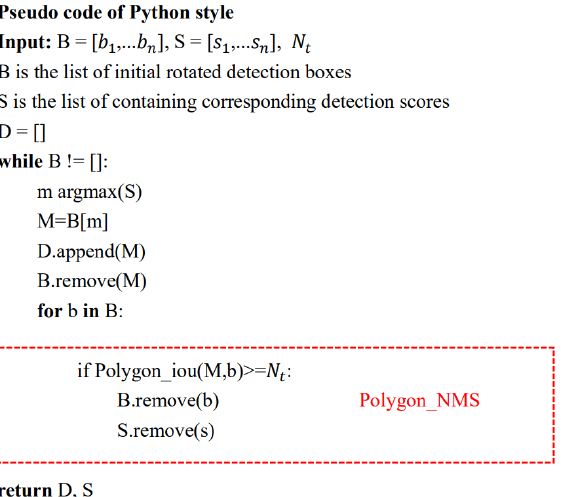
Figure 9. Representation of Polygon NMS through Python-style pseudocode.